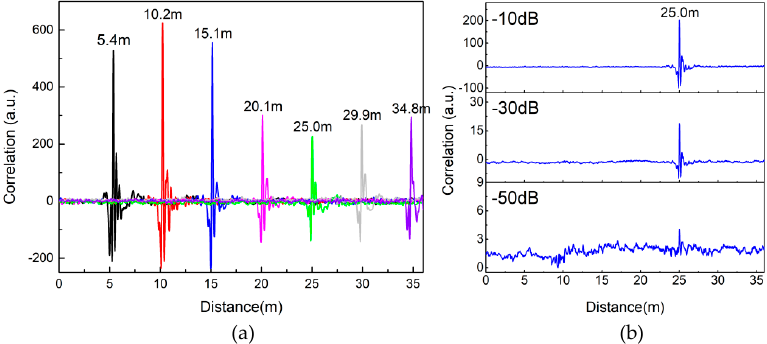
Figure 7. ( a ) Detection results of different intrusion distances. ( b ) Dynamic range analysis of our sensor.